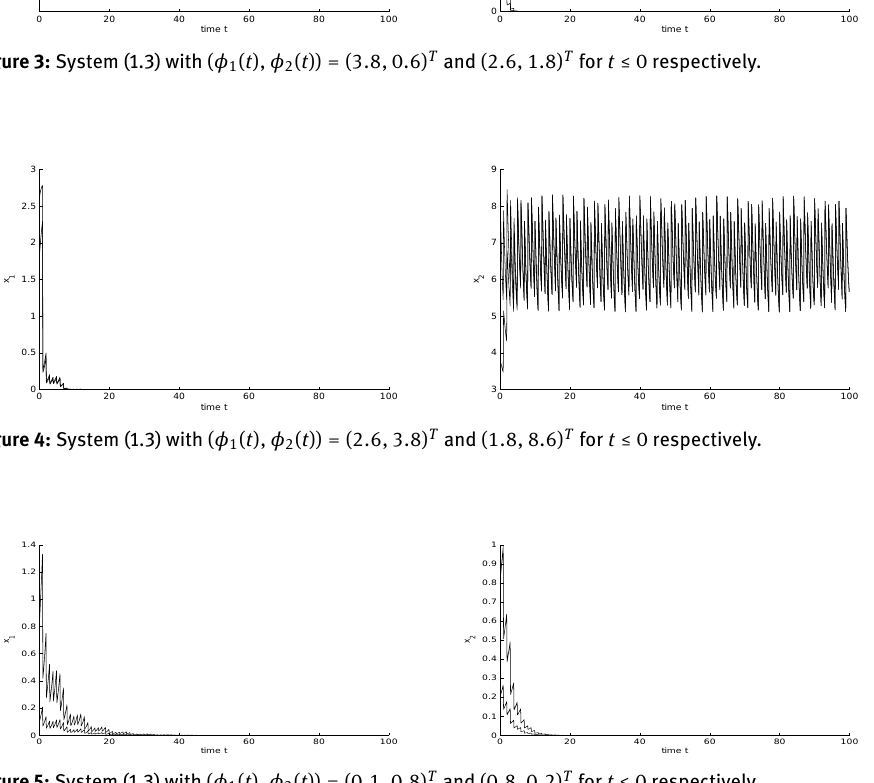
Figure 5: System (1.3) with ( ϕ 1 ( t ), ϕ 2 ( t )) = (0.1, 0.8) T and (0.8, 0.2) T for t ≤ 0